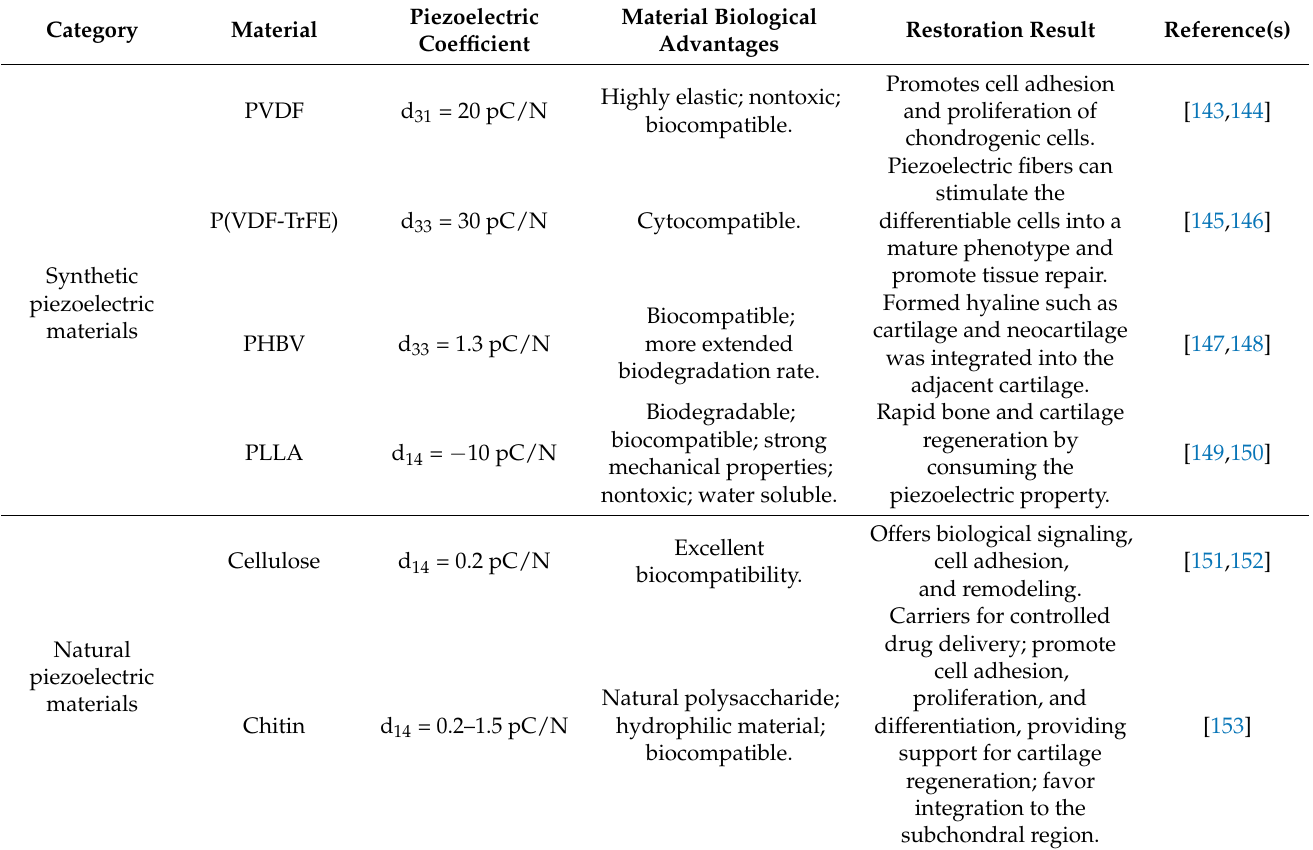
Table 3. The piezoelectric materials used for cartilage